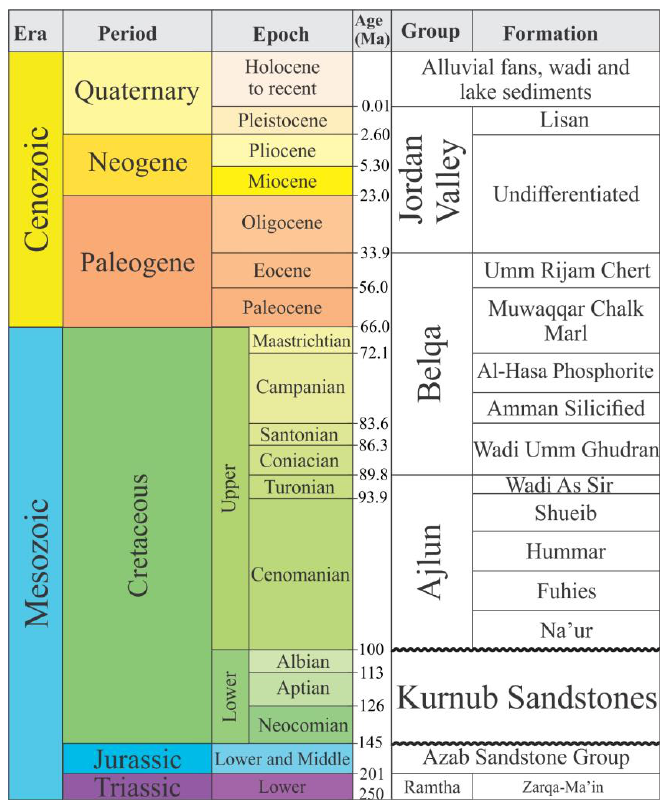
Figure 2. A geologic columnar section of the study area showing the dominant lithologies, groups, and formations and the ages (modified from [50–55,98–100]).